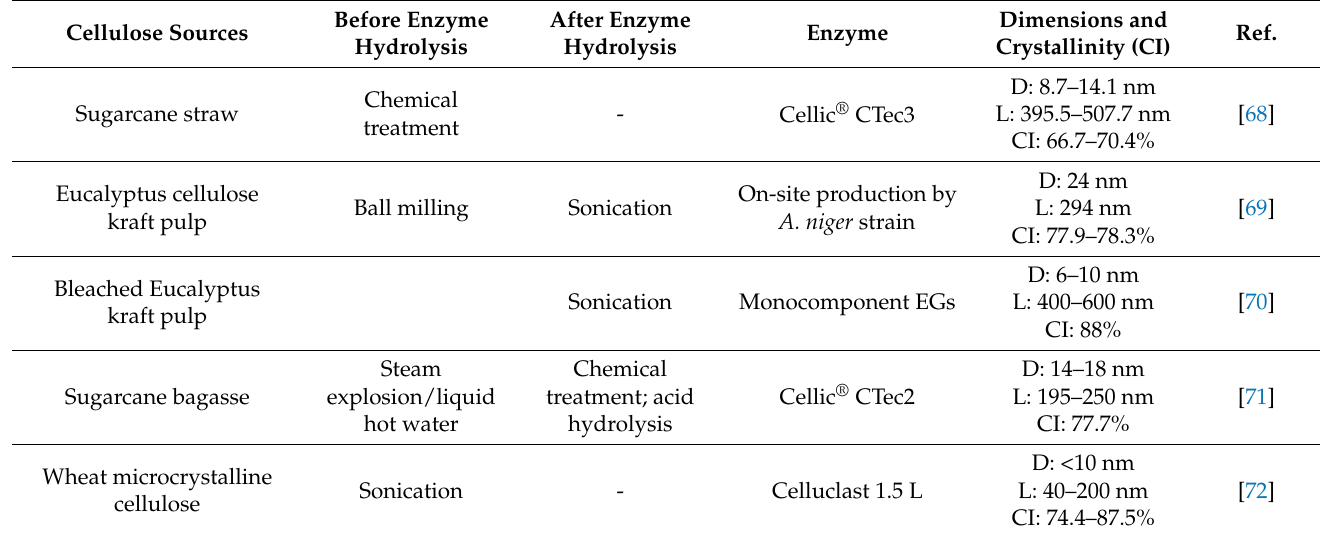
Table 2. List of previous reports regarding enzymatic hydrolysis in CNC production.